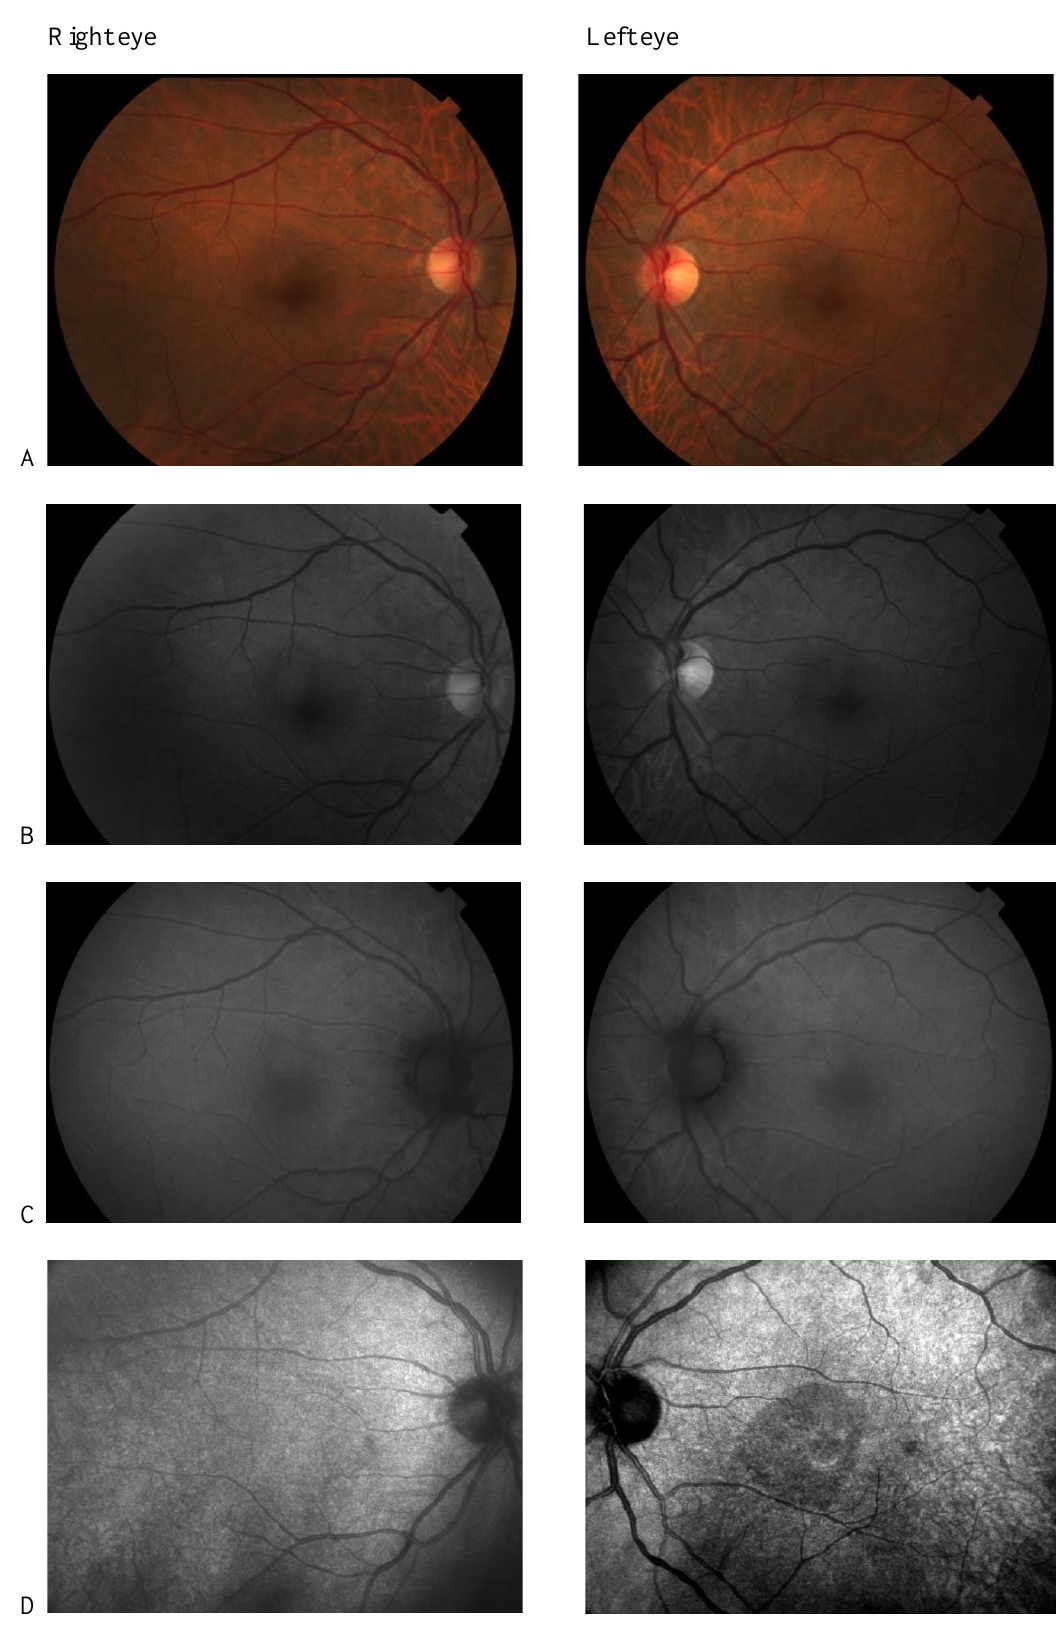
Figure 1. ( A ) Color fundus photography; ( B ) red-free fundus photography; ( C ) fundus autoflu- Figure 1. (A) Color fundus photography; (B) red-free fundus photography; (C) fundus autofluorescence; (D) Scanning orescence; ( D ) Scanning laser ophthalmoscopy (SLO) fundus image revealed abnormal macular laser ophthalmoscopy (SLO) fundus image revealed abnormal macular reflectivity in the left eye. reflectivity in the left